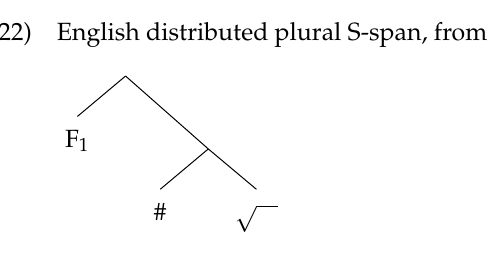
√ root and exponent L-spans for English plurals.